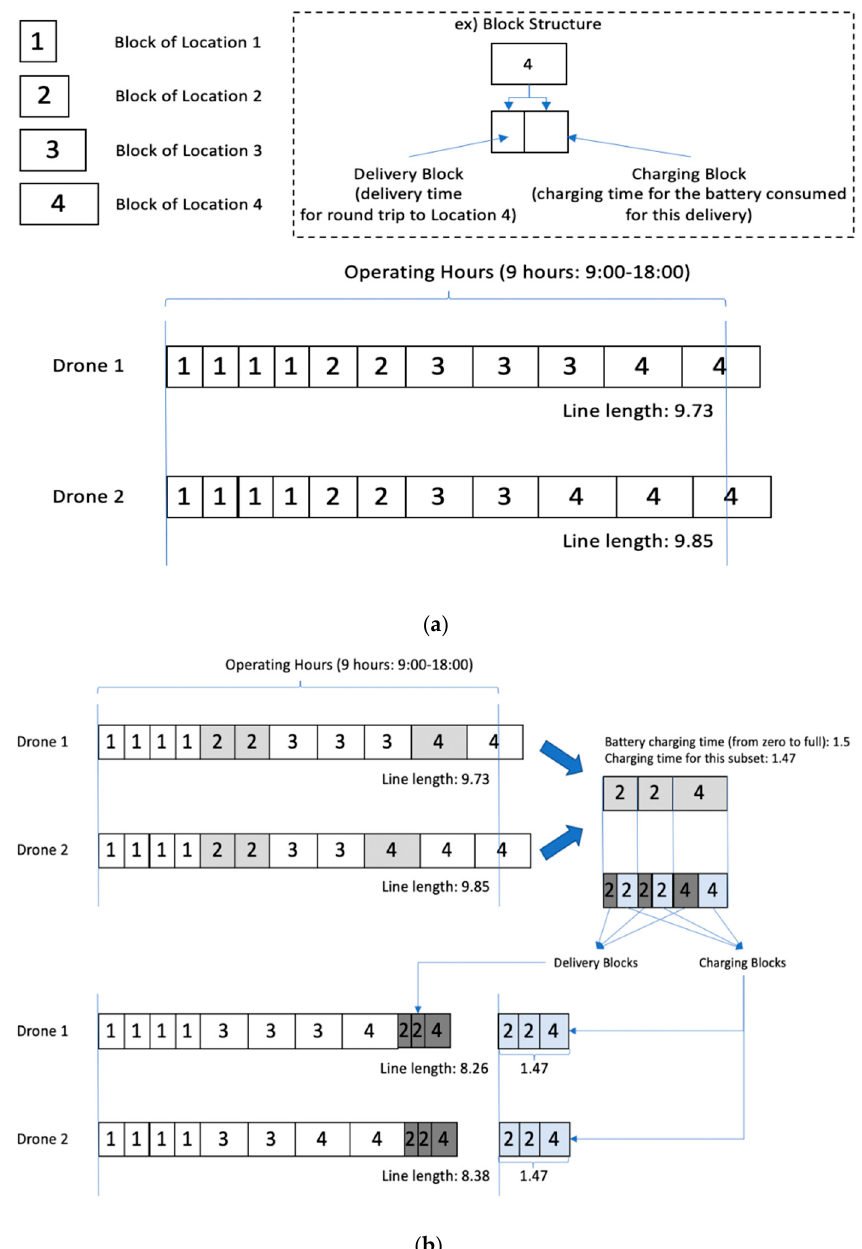
Figure 2. Building a solution by stacking blocks . ( a ) Initial block stacking; ( b ) grouping and relocation.